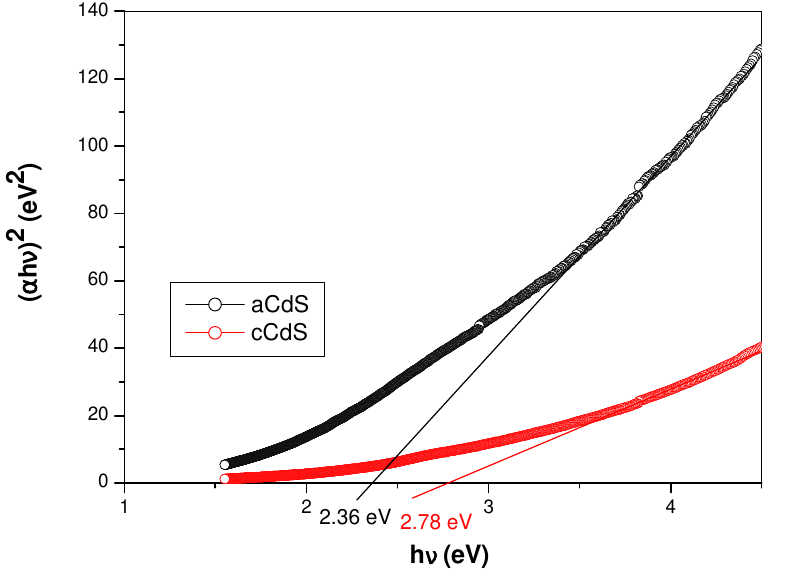
Figure 5. Tauc’s plots with the determined bandgap energy of aCdS and cCdS samples. UV-Vis absorption spectra of aCdS and cCdS samples (Figure 4) exhibit a broad absorption in the whole ultraviolet-visible region with the absorption maximum in the visible region. Figure 4 shows UV-Vis spectra with a clearly higher intensity of light absorbance evidenced in the case of the aCdS sample, in comparison with cCdS. The optical band gap, E g , was determined based on the Tauc Equation (2) for directly allowed optical transition, α h ν = A (h ν − E g ) 1/2 , by the plotting ( α h ν ) 2 against photon h ν energy and extrapolating the slope in the band edge region to zero, as shown in Figure 5. The optical bandgap was determined to be 2.36 eV for aCdS and 2.78 eV for cCdS, respectively. The optical bandgap of aCdS sample is red-shifted and cCdS is